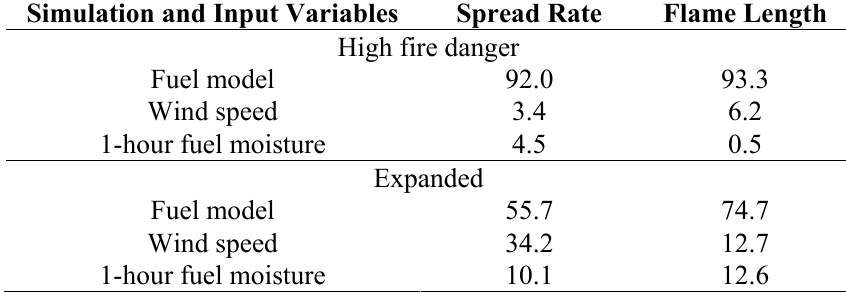
Table 6. CART analyses results: relative contributions (%) of fuel model, wind speed and 1-hour fuel moisture content in explaining variability in modeled fire behavior